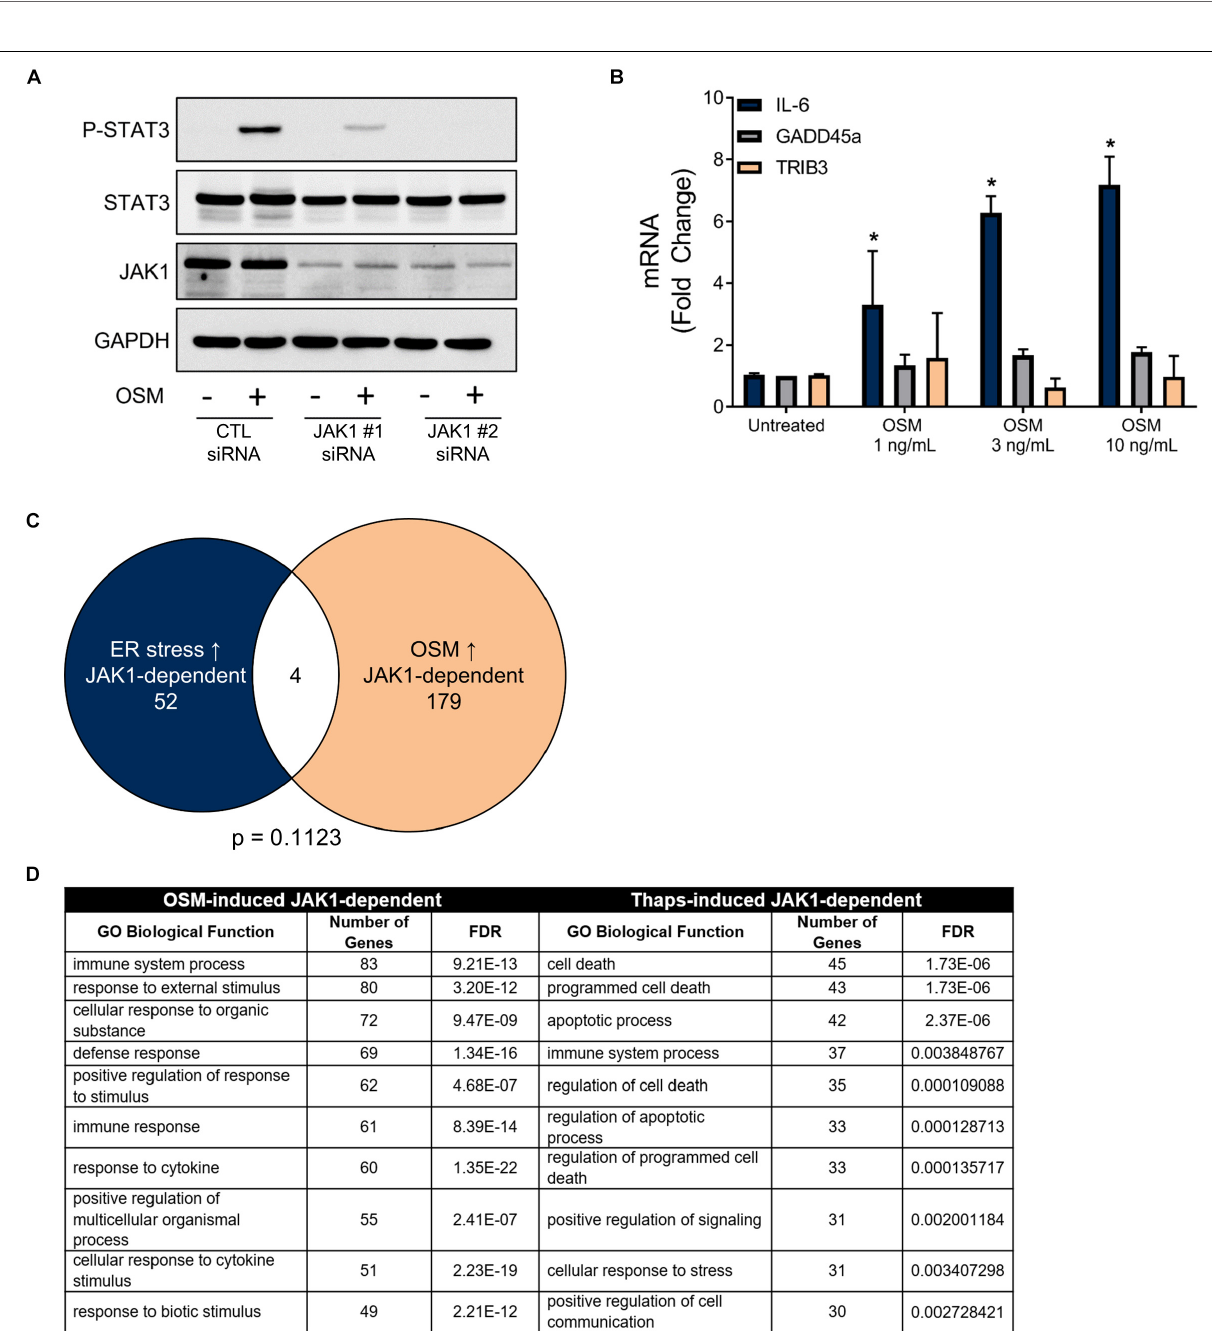
FIGURE 4 | ER stress induces a unique JAK1-dependent gene expression profile that is distinct from OSM-induced JAK1-dependent gene expression. (A) Primary astrocytes were transfected with Control (CTL) or one of two distinct JAK1 siRNAs for 48 h and stimulated with OSM for 30 min followed by immunoblotting. (B) Astrocytes were stimulated with OSM at the indicated concentrations for 4 h. Gene expression was measured by RT-qPCR. Data are represented as means ± standard deviation. N = 3. ∗ p ≤ 0.05. (C) Astrocytes were transfected with CTL or JAK1 siRNA#2 and treated with OSM (2.5 ng/ml) for 4 h. Gene expression was then measured by RNAseq to identify the JAK1-dependent genes. Venn diagram of JAK1 dependent genes in response to ER stress or OSM. (D) Gene ontology analysis of the genes represented in (C)